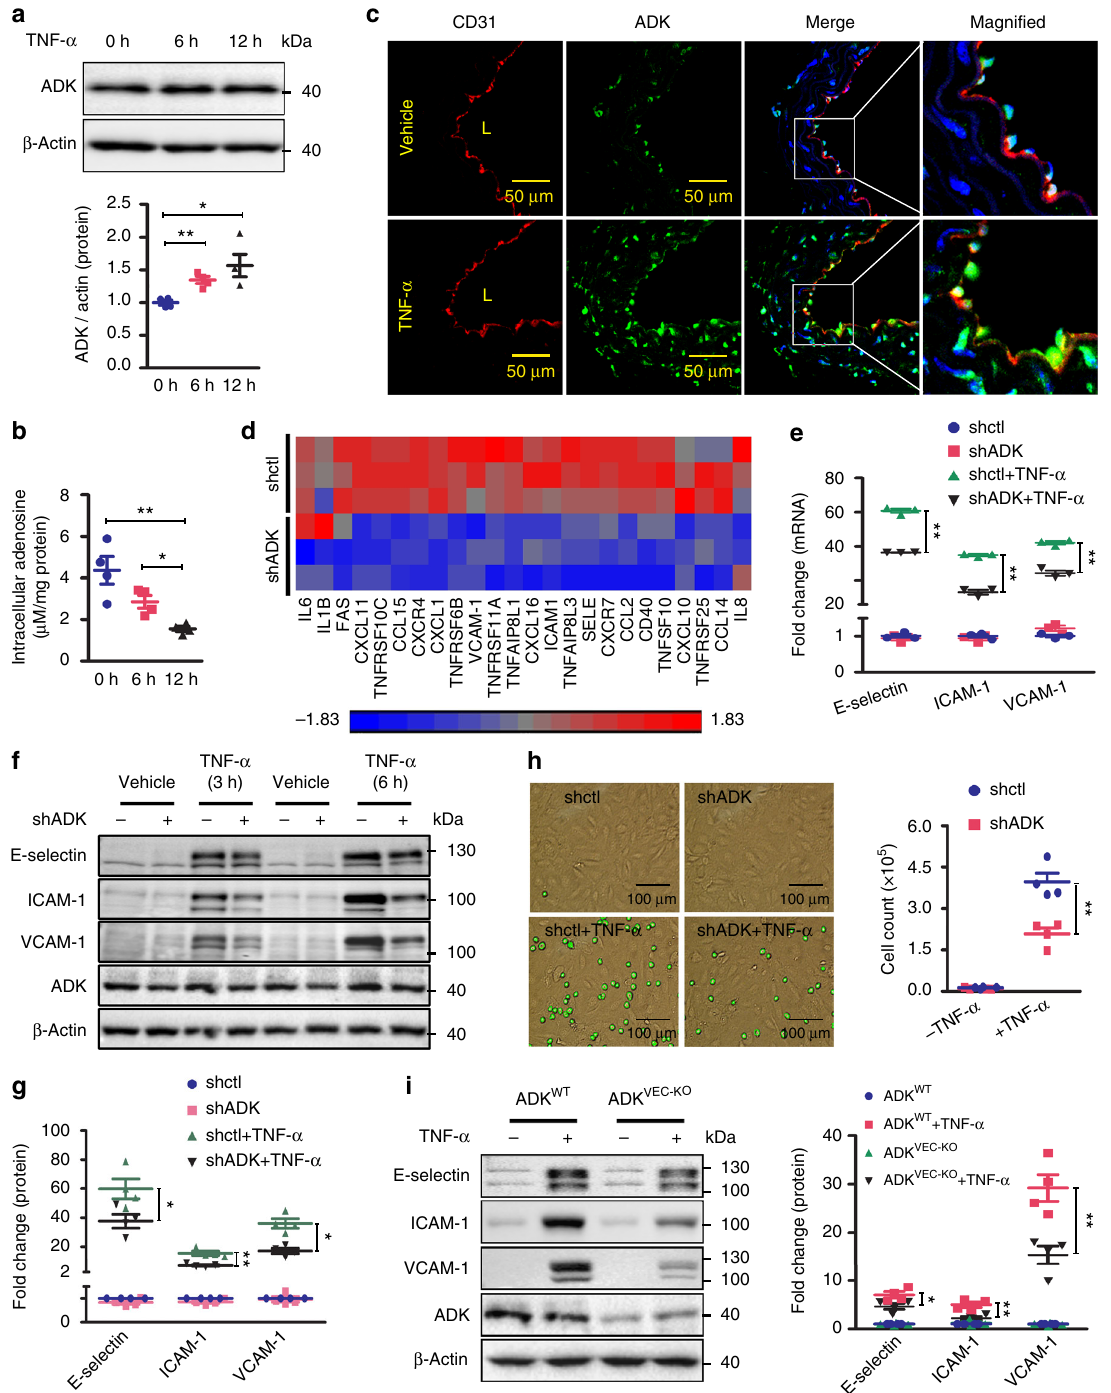
Fig. 1 ADK de fi ciency suppresses endothelial in fl ammation in vitro. a Western blot detection of ADK in HUVECs treated with TNF- α at 10 ng/ml ( n = 4). b Quanti fi cation of intracellular adenosine by HPLC in HUVECs exposed to TNF- α at 10 ng/ml ( n = 4). c Representative images of ADK immuno fl uorescent (IF, green ) staining on aortic endothelium (areas indicated with CD31 staining, red ) of WT mice treated with vehicle or TNF- α (10 ng per gram mouse body weight for 5 h). L indicates luminal area ( scale bar , 50 µ m; n = 5 – 6 mice per group). d Heat map of in fl ammation-related genes in ADK KD or Ctrl HUVECs ( n = 3). e RT-PCR analysis of mRNA levels of adhesion molecules in TNF- α (10 ng/ml for 2 h)-treated ADK KD or Ctrl HUVECs ( n = 3). f Western blot detection of adhesion molecules in ADK KD or Ctrl HUVECs treated with TNF- α at 10 ng/ml for 3 or 6 h. Images are representative of four independent experiments. g Quanti fi cation of adhesion molecular expression in ADK KD or Ctrl HUVECs treated with TNF- α at 10 ng/ml for 6 h ( n = 4). h Representative images and quanti fi cation of monocyte adhesion on TNF- α (10 ng/ml for 4 h)-treated ADK KD or Ctrl HUVECs ( scale bar , 100 µ m; n = 4). i Western blot detection and densitometric quanti fi cation of adhesion molecule expression in 10 ng/ml TNF- α -treated MAECs isolated from ADK WT or ADK VEC-KO mice ( n = 4). For all bar graphs , data are the mean ± SEM, * P < 0.05 and ** P < 0.01 (one-way ANOVA with Tukey ’ s post hoc test for a , b ; unpaired, two-tailed Student ’ s t -test for e , i )